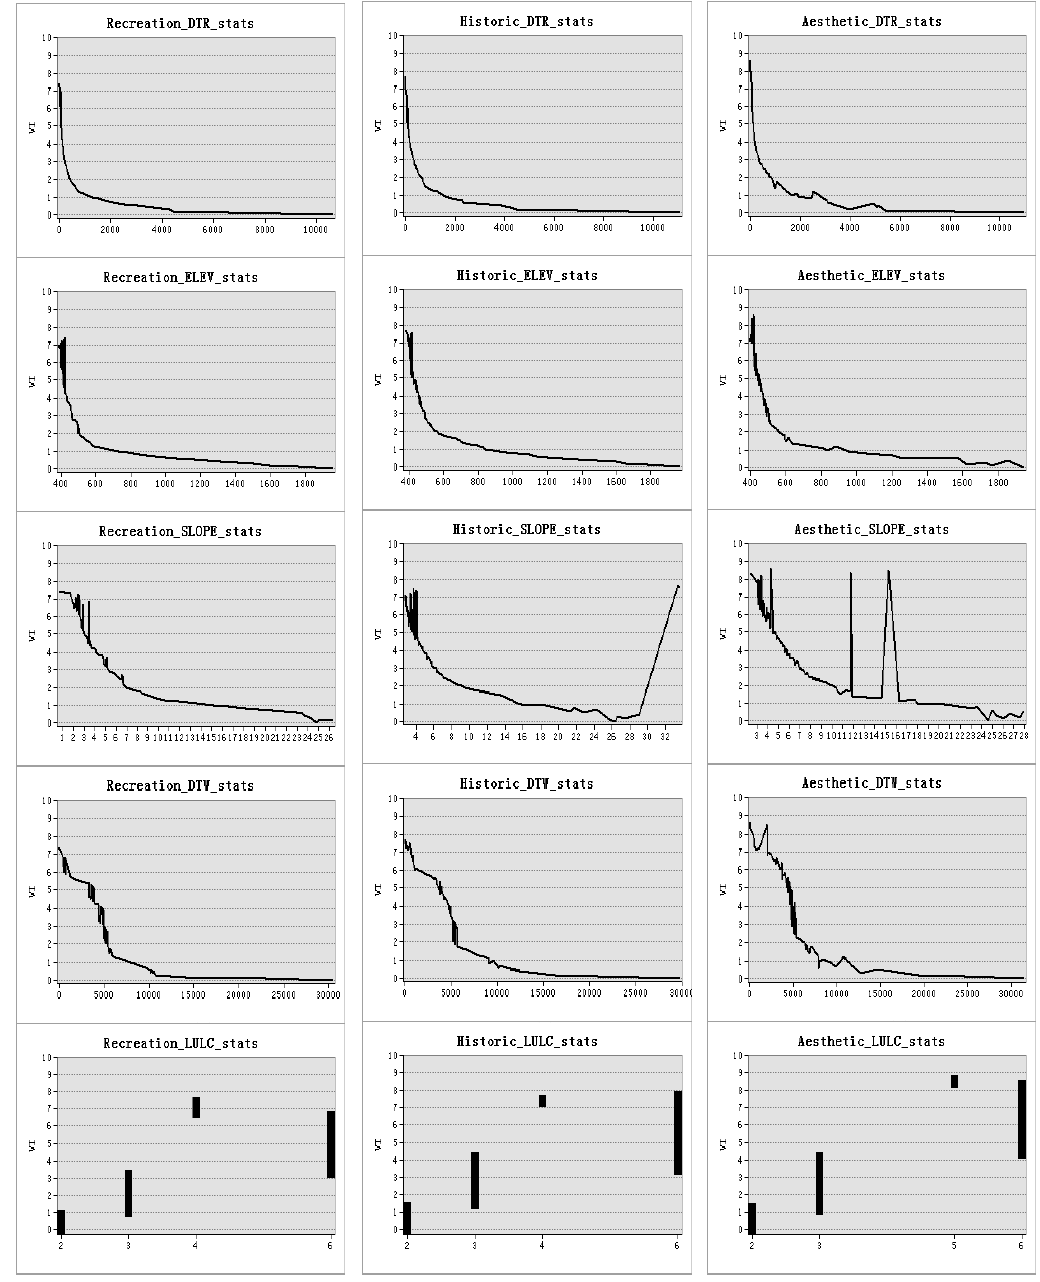
Figure 7. The relationship between CES value and environmental index. Among the types of LULC, 1 represents grassland, 2 represents forest land, 3 represents cultivated land, 4 represents water body, 5 represents unused land, and 6 represents urban land.